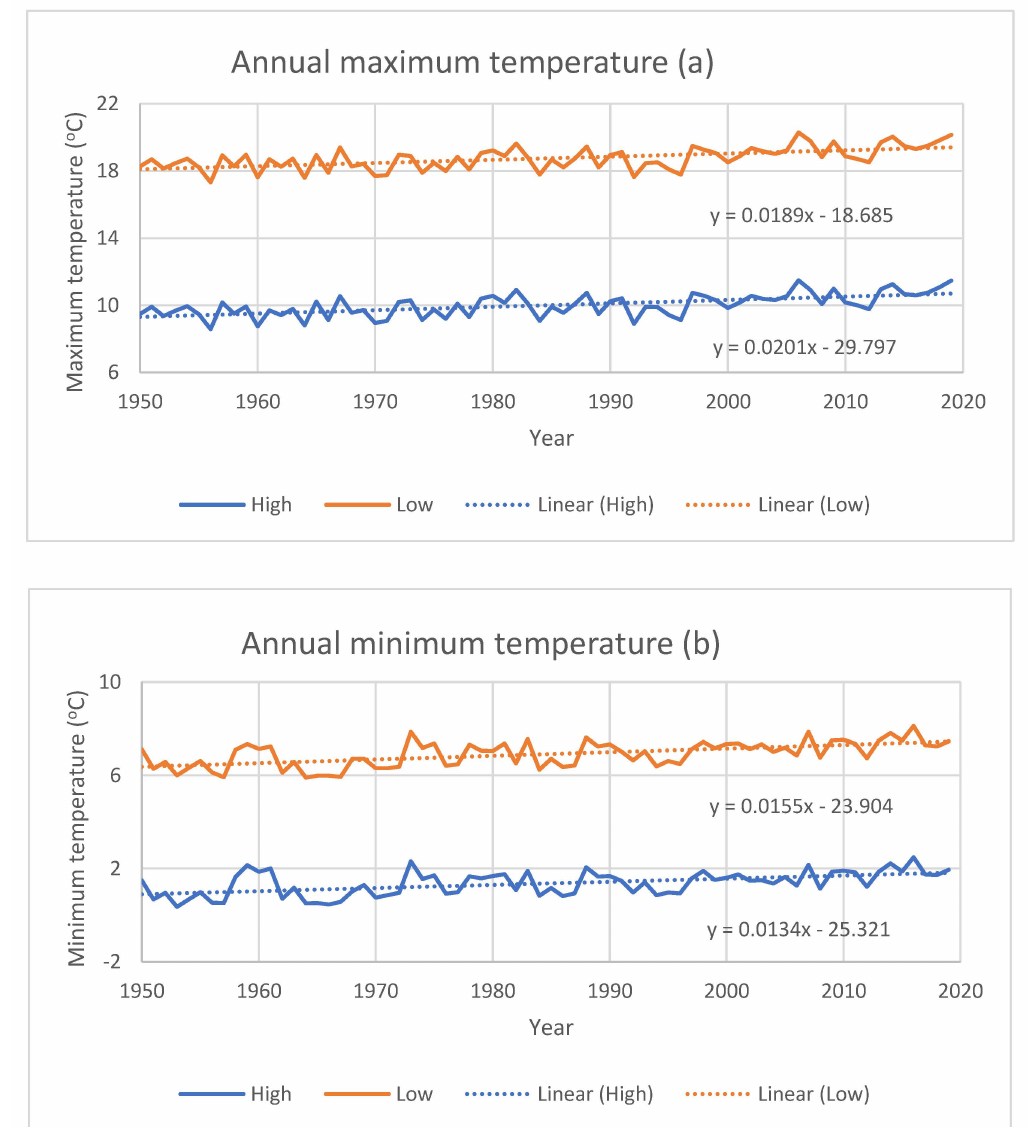
Figure 3. Plots of annual mean maximum ( a ) and minimum ( b ) temperatures for high and low elevation for 1950–2019. The trends are statistically significant using a non-parametric Mann-Kendall test at the 95% confidence